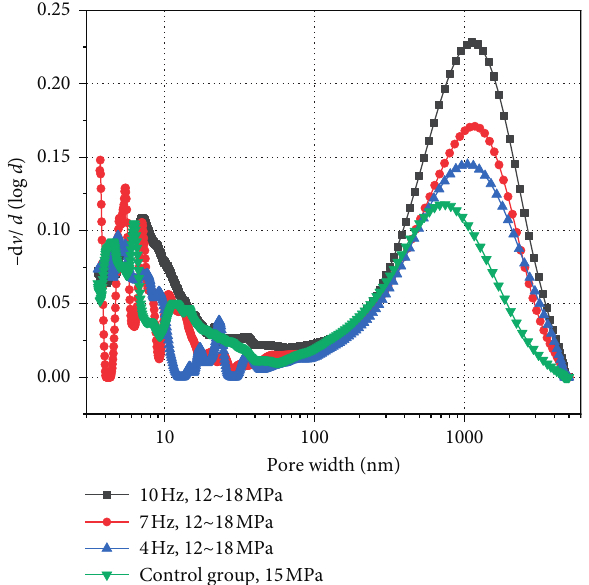
Figure 5: Density functions of pore volume distribution at dif- ferent loading